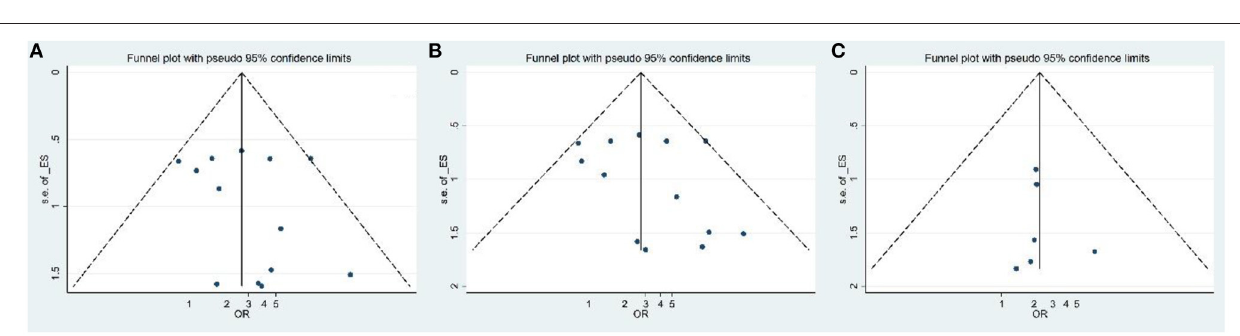
FIGURE 3 | Funnel plot for evaluation of publication bias [ (A) IBD; (B) CD; (C) UC